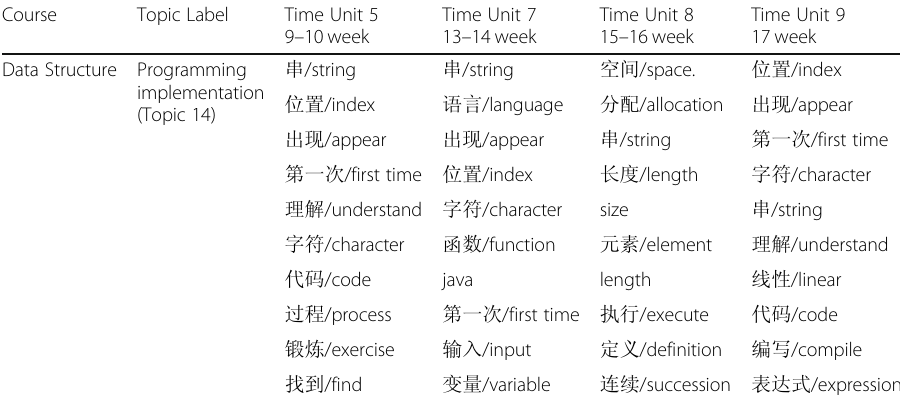
Table 6 The evolution of topic content about programming implementation over time